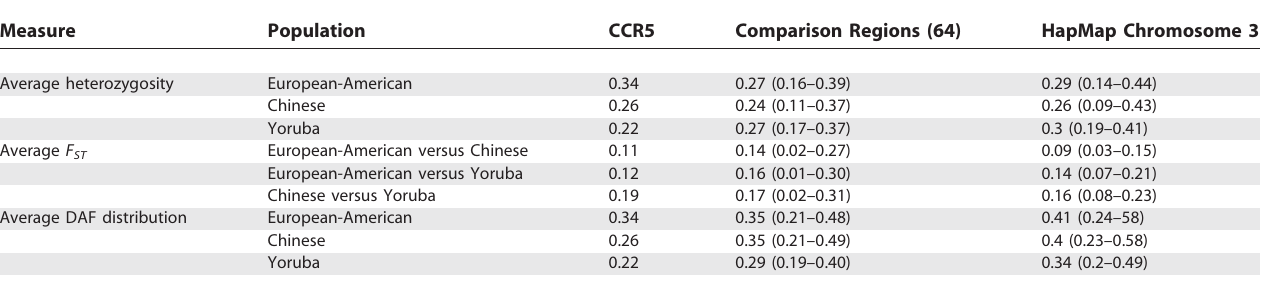
Table 1. Genetic Diversity at CCR5 in Comparison with Genetic Diversity for Regions from Two Large Empirical Datasets Measure